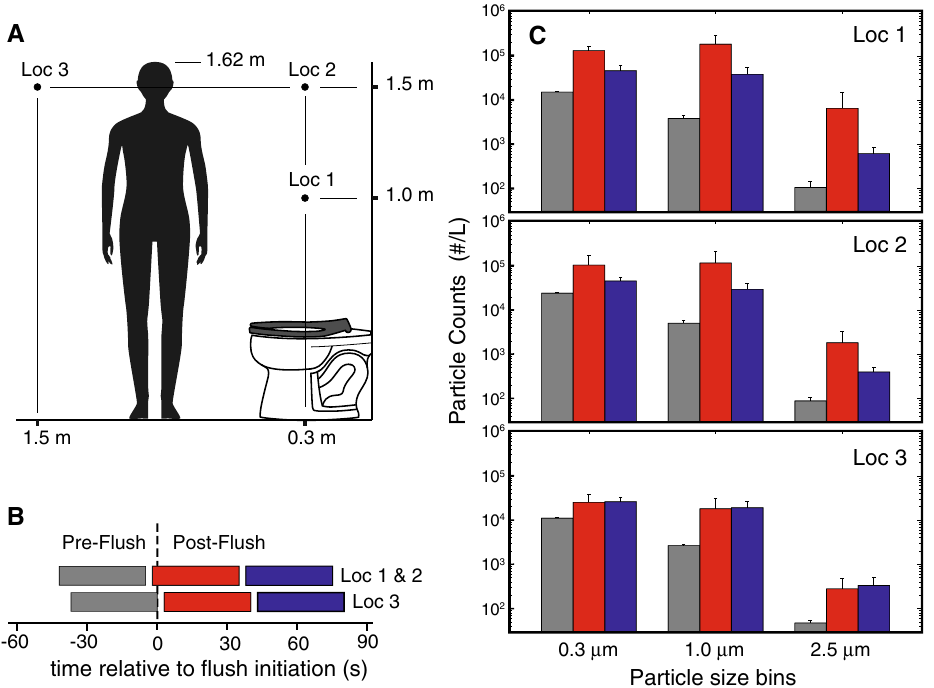
Figure 5. Size and number of ejected aerosol particles. ( A ) An airborne particle counter is used to take particle measurements at indicated locations; Locations 1 and 2 are also shown for reference in Fig. 3. The human figure provided for scale is 1.62 m tall, corresponding to the average height of an American female adult. ( B ) Particle counts are averaged over the indicated 37 s intervals, one pre-flush (gray bars), and two post-flush (red and blue bars). ( C ) Particle counter results are binned into three size categories for each of the three locations. The histogram bars represent the average of five replicates, and the listed size bins correspond